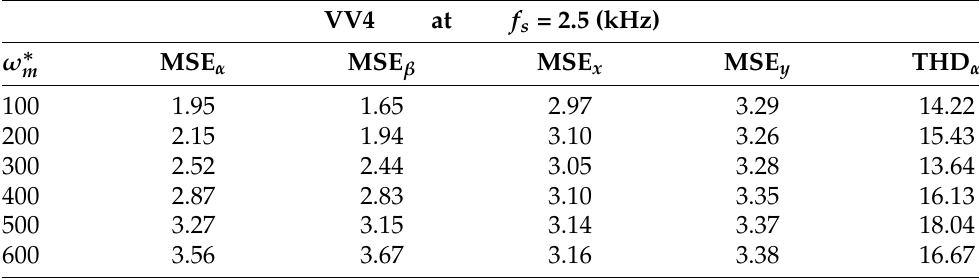
Table 2. Performance indicators for the drive operating from 100 [rpm] to 600 [rpm] for VV4.